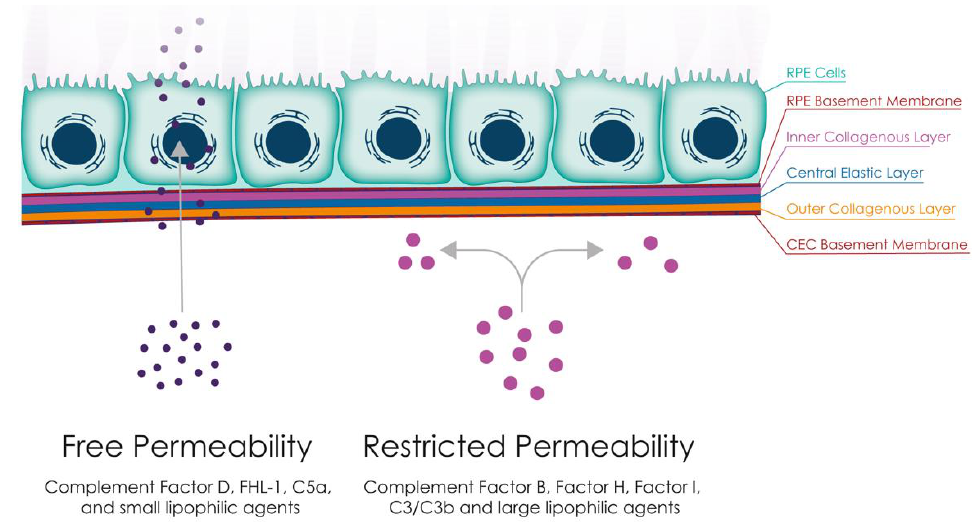
Figure 1. Complement diffusion through BrM. BrM has been shown to act as a barrier between the retina and choroid, allowing a limited number of complement proteins, such as FHL-1, factor D, and C5a, to diffuse through. This compartmentalisation may be exacerbated in ageing and disease, as lipid deposition in AMD has been shown to reduce FHL-1 diffusion. This could create two separate compartments for complement activation and regulation, namely the retinal and choroidal sides, with complement proteins remaining on their side of origin. Abbreviations: FHL-1, Factor H-like 1 protein; RPE, retinal pigment